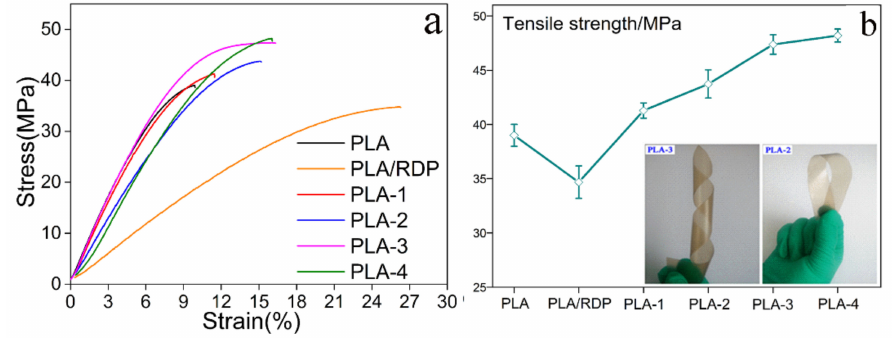
Figure 3. The stress-strain curves ( a ) and tensile strength ( b ) of the nanocomposite films.